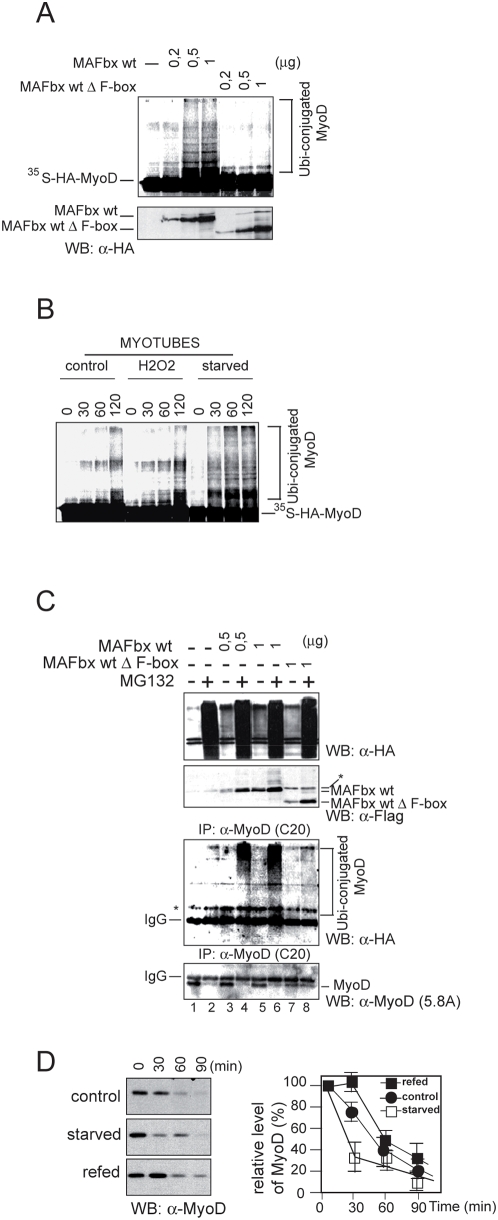
MAFbx promotes polyubiquitination of MyoD in vitro and in cellulo.
A/ MAFbx promotes polyubiquitination of MyoD in vitro. 35S-labeled MyoD was incubated with E1, ATP, ubiquitin and cdc34 (E2) in the presence of increasing amounts of HA-tagged MAFbx or its F-box deletion mutant produced in rabbit reticulocyte extracts. Reaction mixtures were separated on SDS-PAGE, followed by autoradiography (upper panel) and analyzed by Western blotting with anti-HA antibodies (lower panel). B/ Atrophic myotubes lysates promotes polyubiquitination of MyoD in vitro. Myotubes at day 4 of differentiation were treated with H202 (9 h) or were starved for 6 h. Cell lysates were prepared and 30 µg of total proteins were used for in vitro ubiquitination assay on equivalent amounts of 35S-labeled MyoD. Reaction mixtures were separated on SDS-PAGE and followed by autoradiofluorography. C/ MAFbx increases MyoD ubiquitination in cellulo. C2C12 myoblastes were transiently transfected with expression plasmids encoding HA-ubiquitin, Flag-MAFbx wt or the F-box mutant Flag-MAFbx ΔF-box. Transfected cells were treated 3 hours with 30 µM MG132 (+) before harvesting. Cells were lysed in denaturation buffer containing 0.25%SDS. Aliquots (10%) were analyzed by Western blotting with anti-HA and anti-Flag antibodies (upper panels). Cell lysates were then diluted in immunoprecipitation buffer, subjected to immunoprecipitation with a polyclonal anti–MyoD antibody (C-20), and analyzed by Western blotting with anti-Flag antibodies and monoclonal anti-MyoD (5.8A) (lower panels). D/ Increasing instability of MyoD in atrophic C2C12 myotubes. Myotubes at day 4 of differentiation were starved for 6 h. Medium was replaced in refed cultures for 15 h. Myotubes were incubated in methionine-free media for 1 h and then pulsed with 300 µCi/ml of (35S)–labeled methionine for 1 h. Following this incubation, cells were washed with media containing an excess of cold methionine (10 mM) and chased for the indicated time. Cell lysates having the same radioactive counts were subjected to immunoprecipitation with the anti-MyoD antibodies (C-20). MyoD was analyzed by SDS-PAGE, followed by autoradiofluorography.